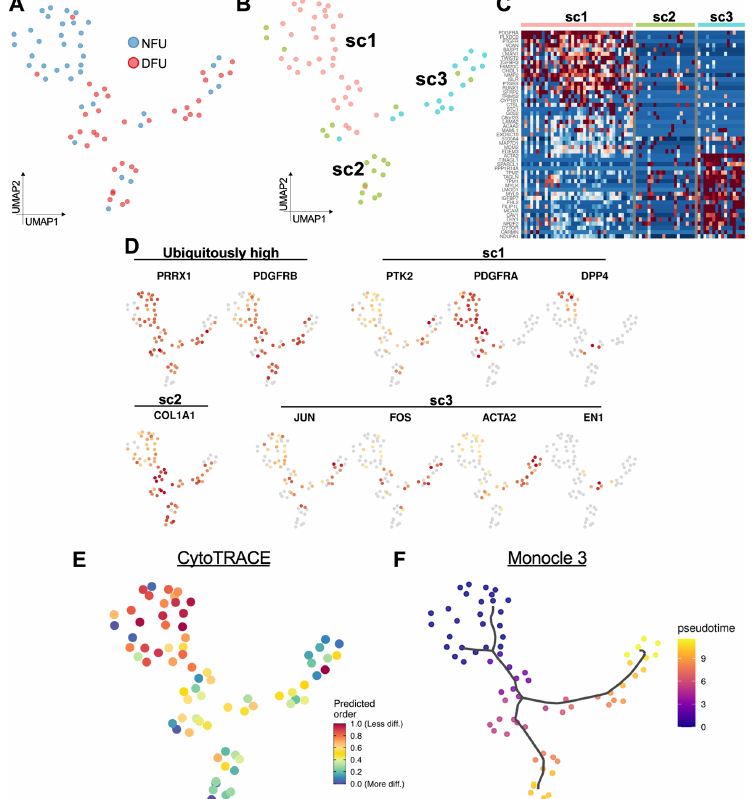
Figure 5. Diabetes alters the distribution of fibroblast subpopulations . ( A ) UMAP of refined fibroblasts by experimental group. ( B ) Re-clustering of these cells reveals three subclusters ( sc1–sc3 ). ( C ) Heatmap of differential genes between the three subclusters. ( D ) Feature plots of genes show fibroblast subpopulations previously characterized by our laboratory and others. ( E ) CytoTRACE analysis shows di ff erentiation potential of these cells. ( F ) Monocle 3 pseudotime analysis shows diverging transcriptional trajectories of wound